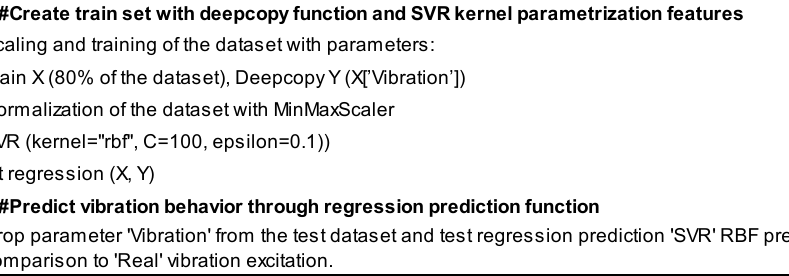
Figure 9. The pseudocode of the SVR algorithm. The graphical representation of the SVR RBF’s ability to predict the machine ‘Vibra ‐ tion’ trend is displayed in Figure 10. The SVR trend behaviour in the fi gure presents four hundred (400) vibration data points formulated based on the input data presented in pseudocode step three. Due to the collection frequency of 5 Hz during the data collection, the visualised 400 data points correspond to approximately 1.3 min of the milling opera ‐ tion.